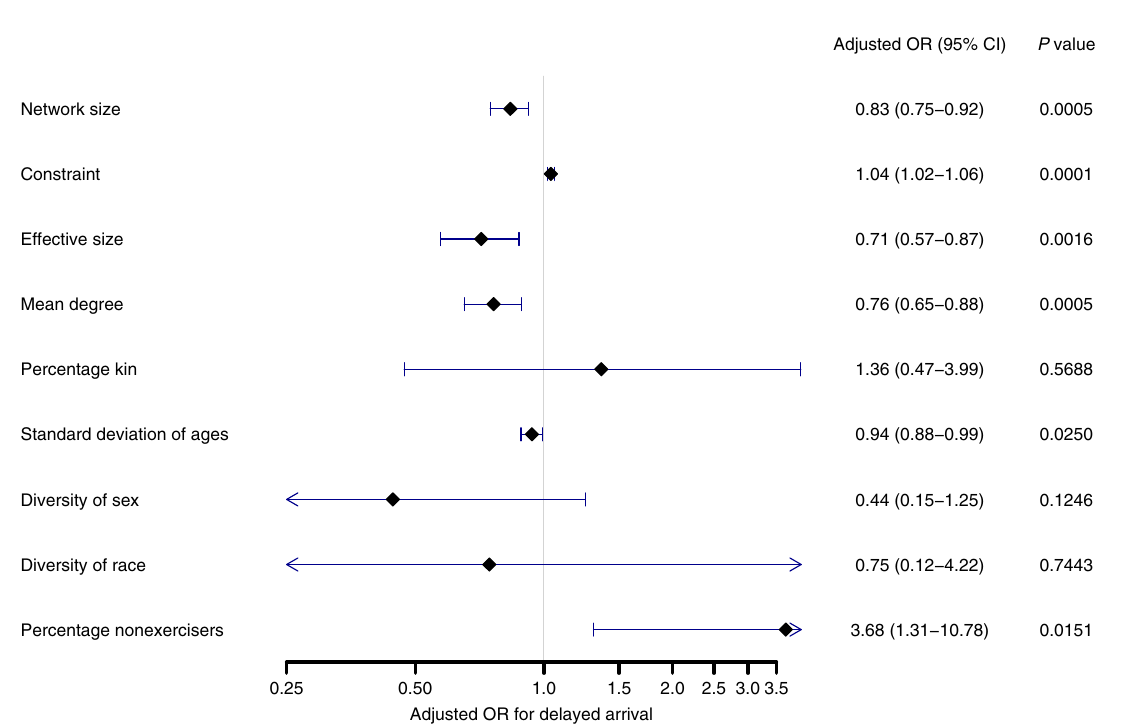
Fig. 3 Forest plot of network metrics and risk of delayed arrival (>6 h). Each diamond is the odds ratio (OR) and each line is the 95% con fi dence interval (95% CI) of a network metric after adjustment for covariates. P values calculated from multivariable logistic regression. Network structure characteristics ( fi rst four rows), more than network composition characteristics, were associated with delayed